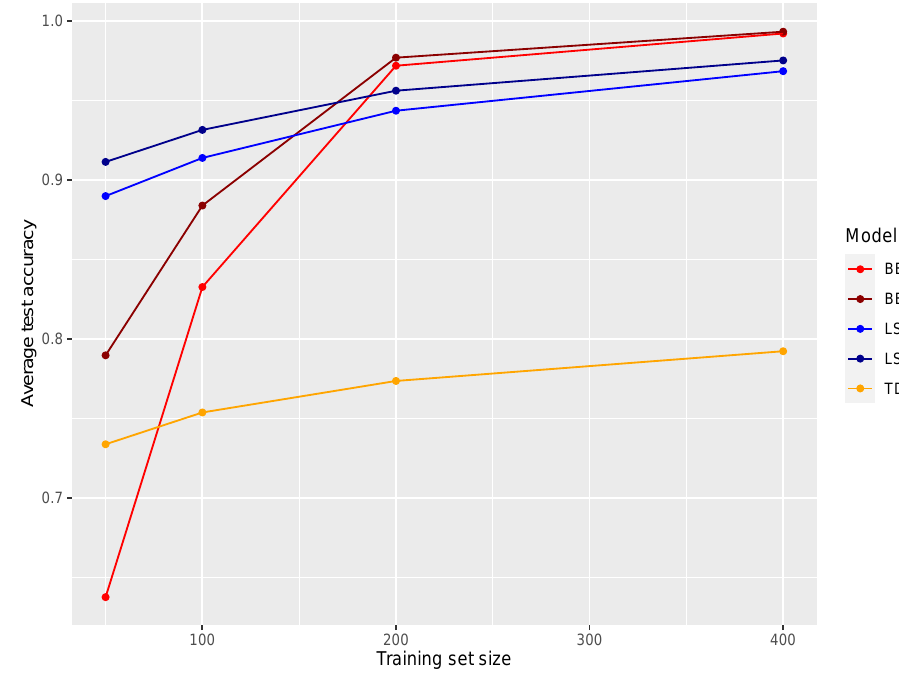
Figure 7. Average test accuracy vs. training set